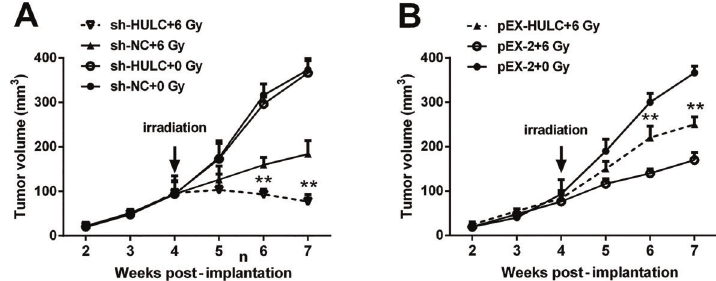
Figure 4. HULC knockdown enhanced the sensi- tivity of PC3 xenografts to irradiation. Tumor volume after irradiation was reduced by HULC knock- down ( A ) but was increased by HULC over- expression ( B ). Data are reported as mean ± SD. **P o 0.01 ( t -test). HULC: long non-coding RNA highly upregulated in liver cancer; sh-HULC: pGPU6/GFP/Neo plasmid carrying short-hairpin RNA targeting HULC; sh-NC: pGPU6/GFP/Neo plasmid carrying a non-targeting RNA; pEX- HULC: pEX-2 plasmid carrying full-length